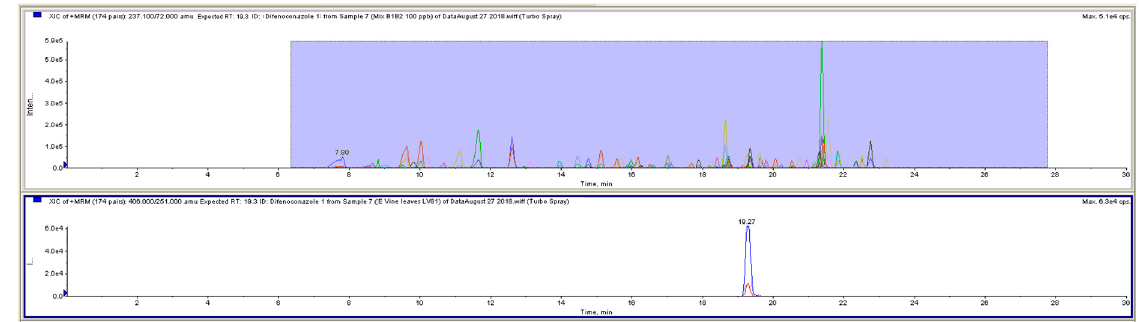
Figure 3. Total Ion Chromatogram (TIC) of the MRMs for the pesticide mixture at 100 µg/L (upper figure) and the Extracted Ion Chromatogram for the difenoconazole in a vine leaves sample (lower figure).